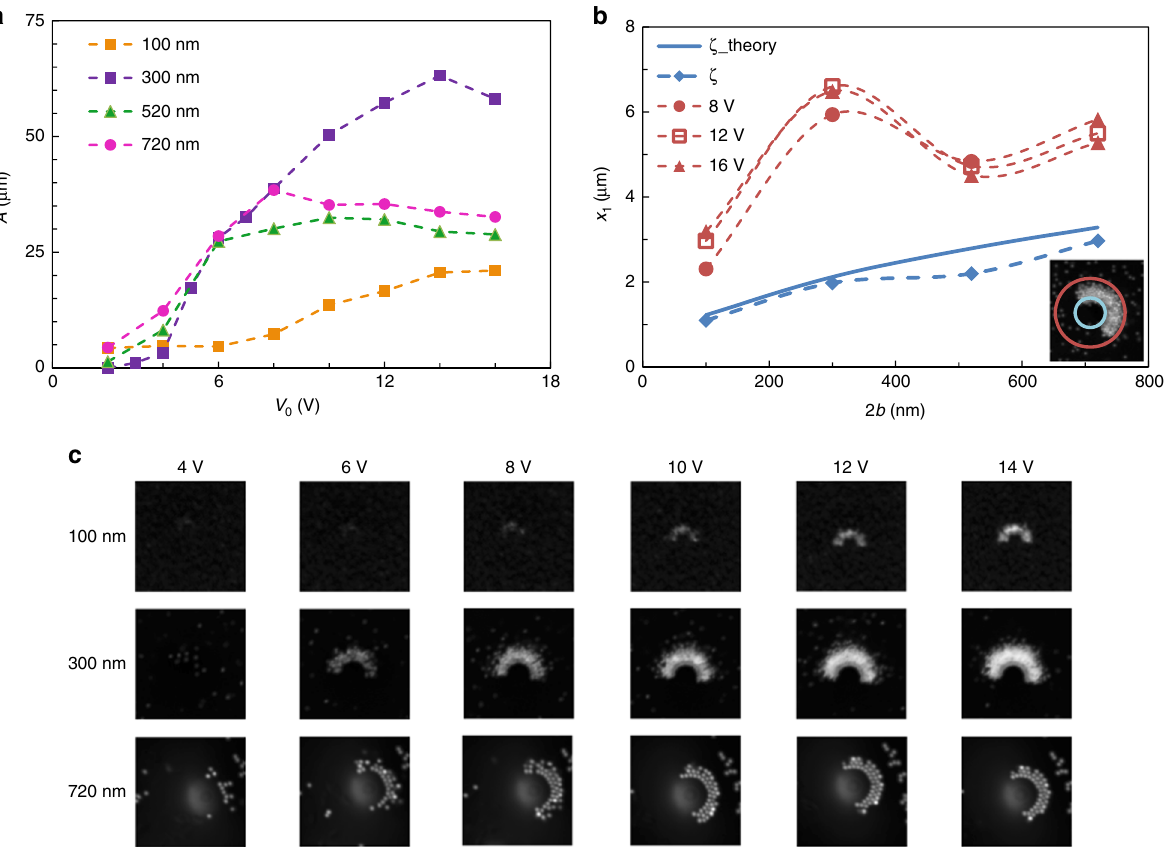
Fig. 3 Dependency of cargo loading on target size and applied voltage. a Plot of area of accumulated targets of varying diameter around a 15 µ m Janus sphere as a function of applied voltage. b Measured (blue markers) and predicted (solid blue line) minimum radius at which targets accumulate and maximum radius (red markers) for various applied voltages. c Microscope images of 100, 300, and 720 nm targets accumulated around a 15 µ m Janus sphere for applied fi elds ranging between 4 and 14 V re fl ecting a sample of the experimental data used to determine part